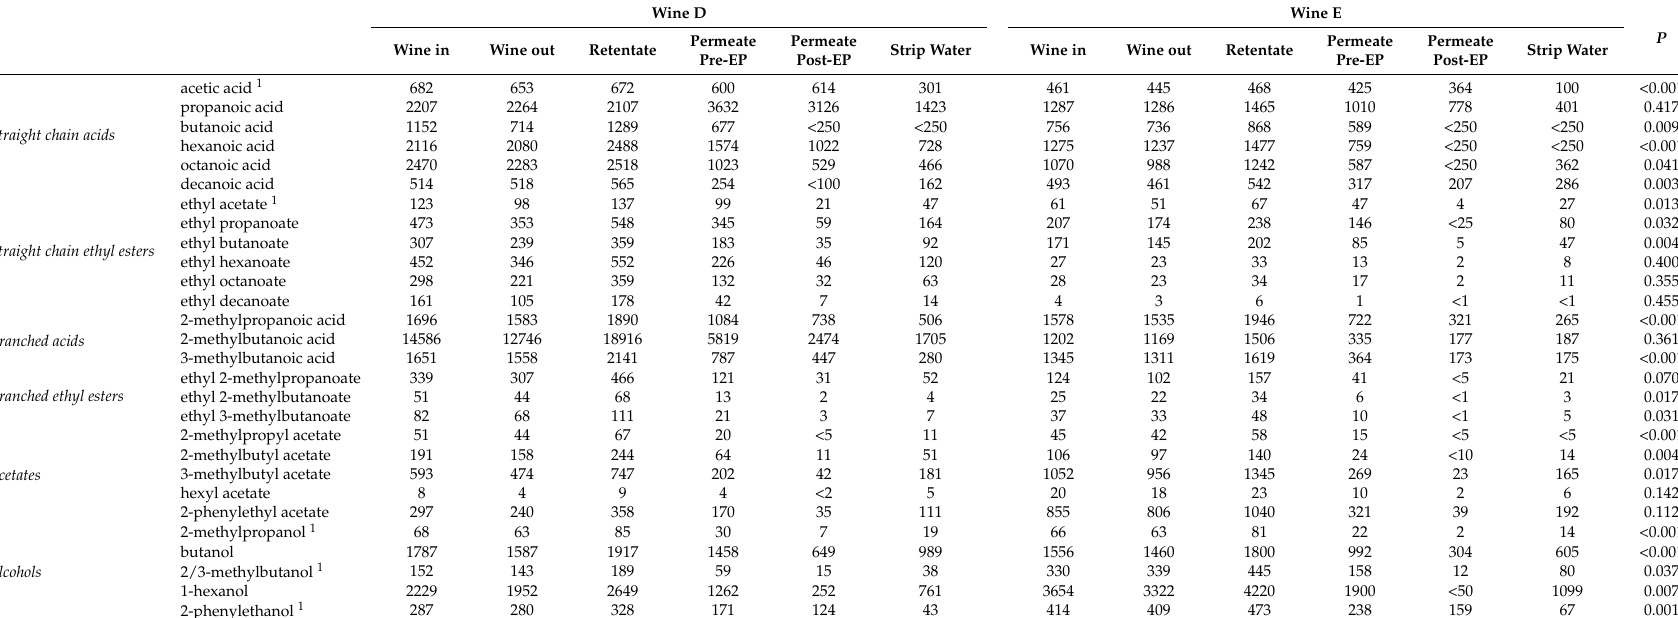
Table 4. Concentrations of fermentation volatiles present in samples collected during RO-EP treatment of Trial 2